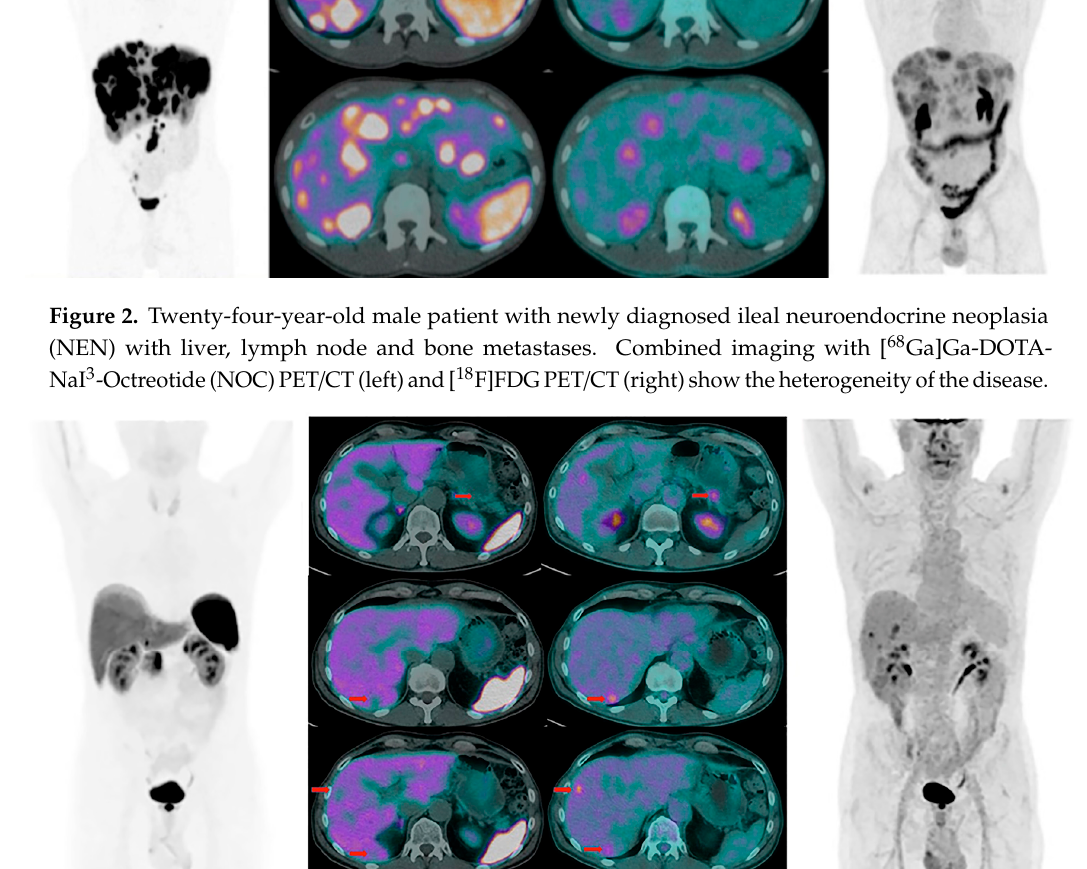
Figure 3. Sixty-seven-year-old male patient with newly diagnosed pancreatic neuroendocrine tumors (NET) with liver metastases. All lesions are positive at [ 18 F]FDG PET/CT (right) and negative at [ 68 Ga]Ga-DOTA-NOC PET/CT (left), indicating a more aggressive and un-differentiated disease.